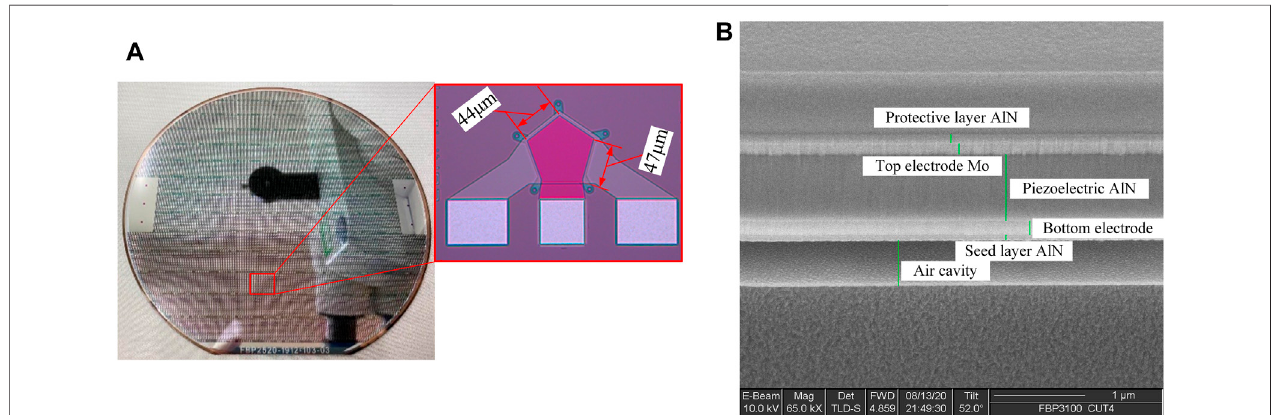
FIGURE 7 | Photographs of the fabricated FBAR: (A) wafer; (B) cross section as seen under a SEM.